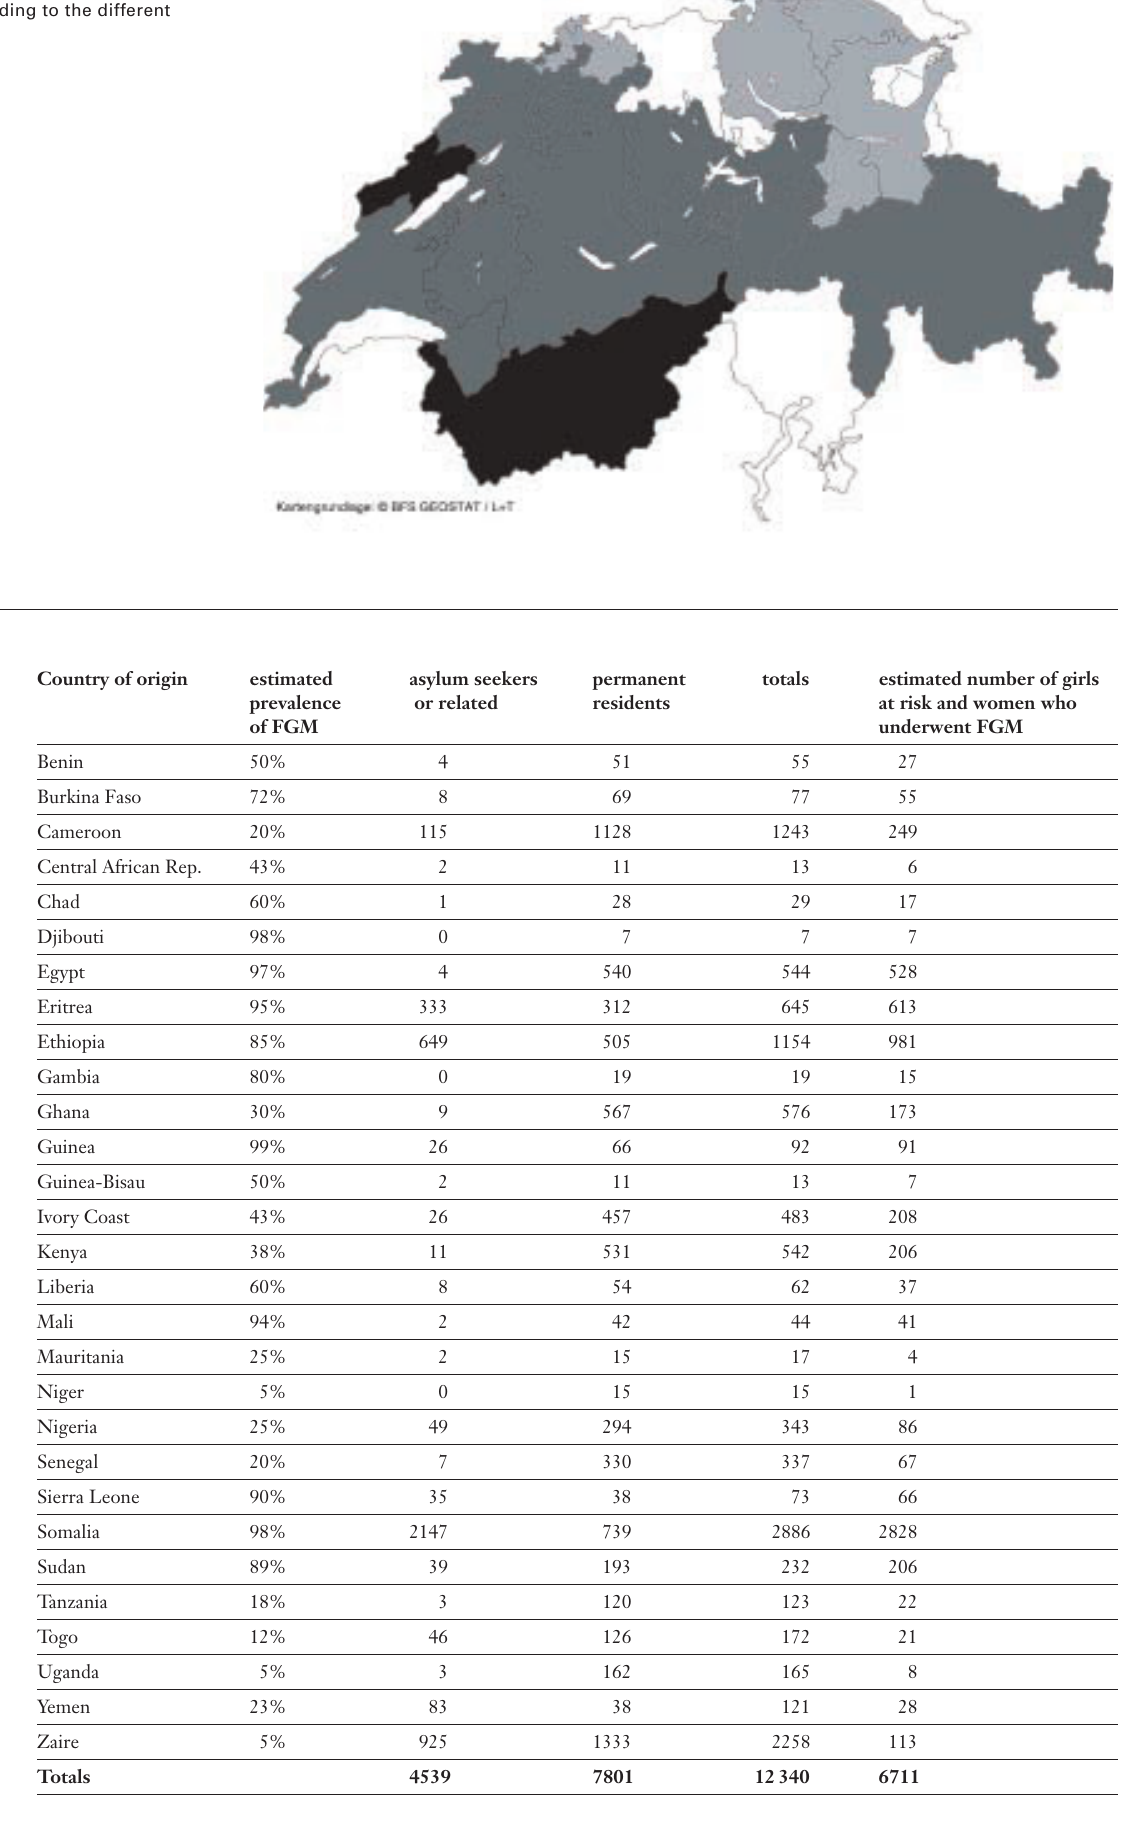
Confrontation rates for FGM among Swiss Gynaecologists according to the different Cantons.